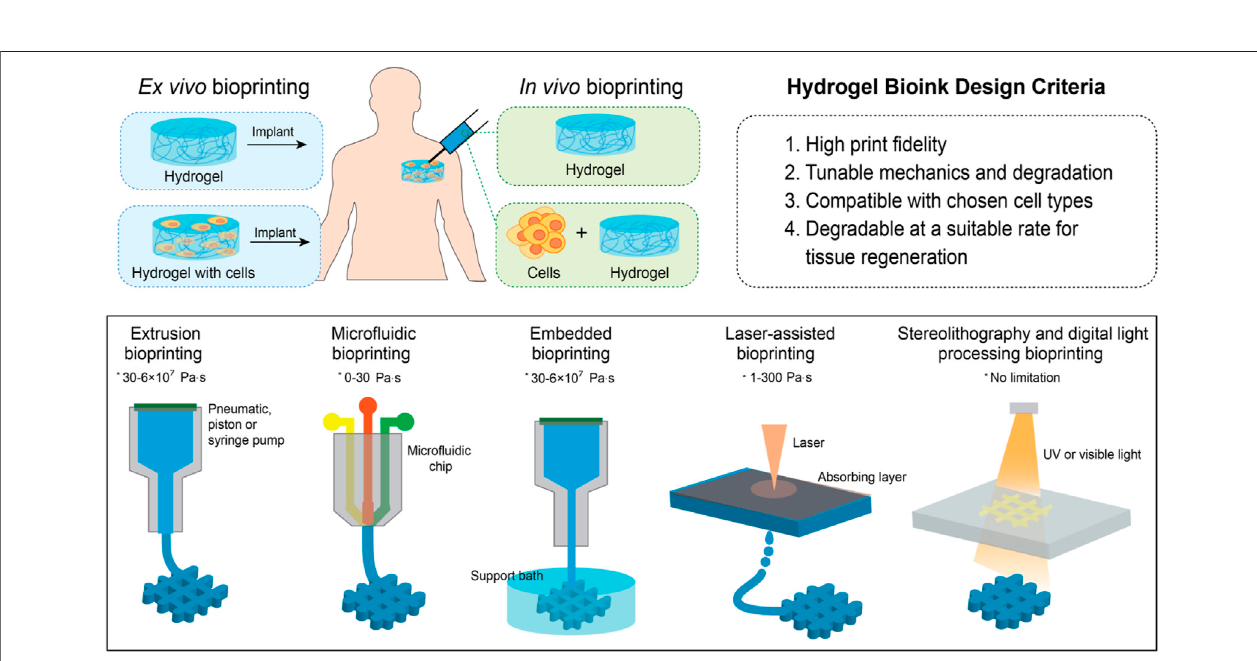
FIGURE 4 | Schematic of ex vivo and in vivo bioprinting techniques (* represents the viscosity range of bioinks useful for each bioprinting technique).